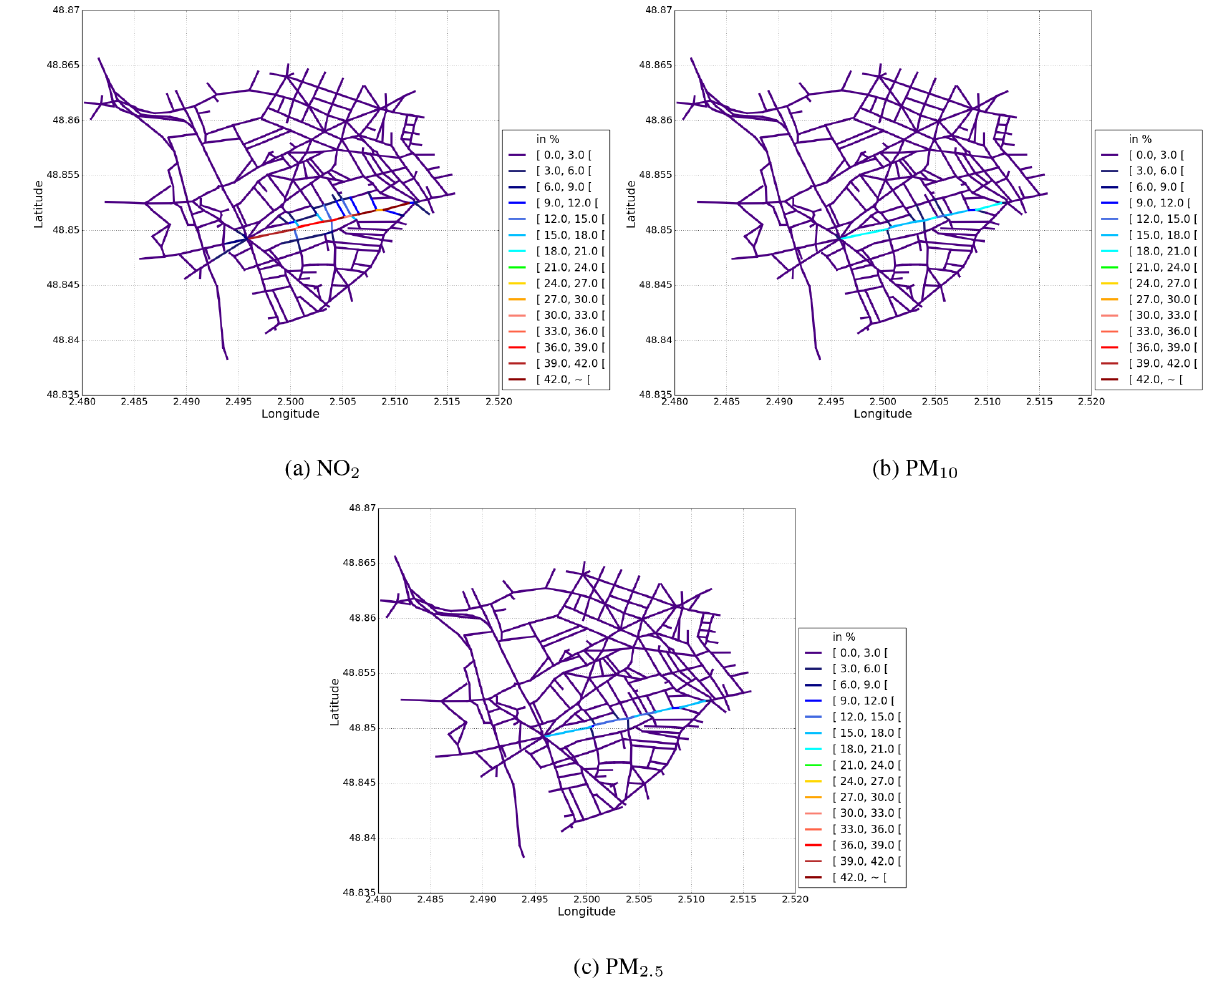
Figure 13. Temporal NME (in %) between Case-1 and Case-12 for (a) NO 2 , (b) PM 10 , and (c) PM 2 . 5 . The absolute differences in the concentrations between the simulations are presented in additional figures in Appendix